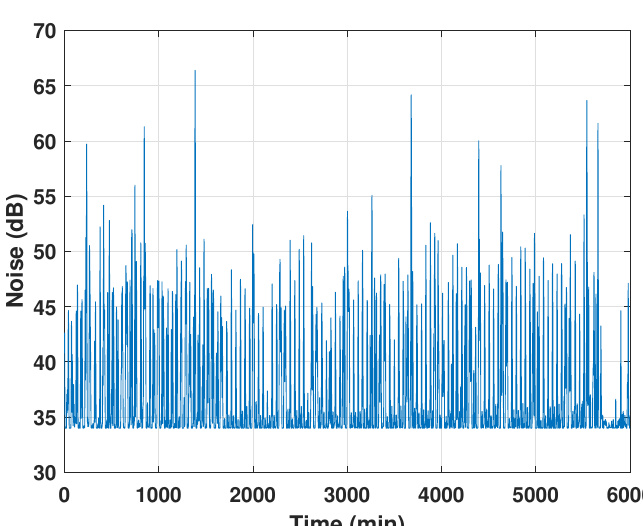
Figure 1. Overview of the CO 2 set points.